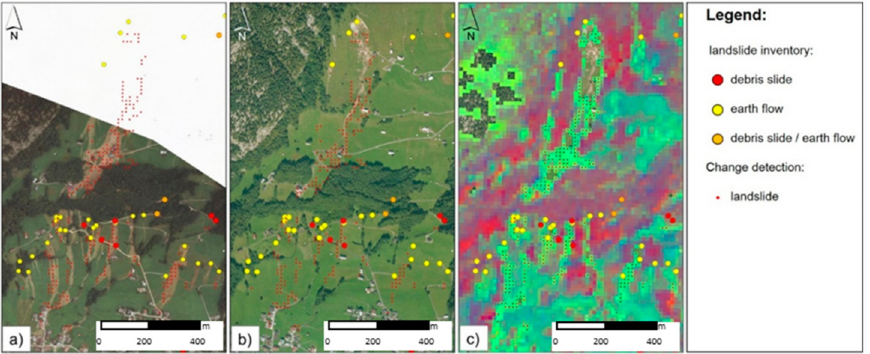
Figure 15. Landslide classification results in the area around the village Au within the central study area (purple areas E and F) (as seen in Figure 9) overlaid to the aerial-photo 2005 ( a ), 2006 ( b ) and 09.2004–09.2005 ( c ) (Aerial-photos©